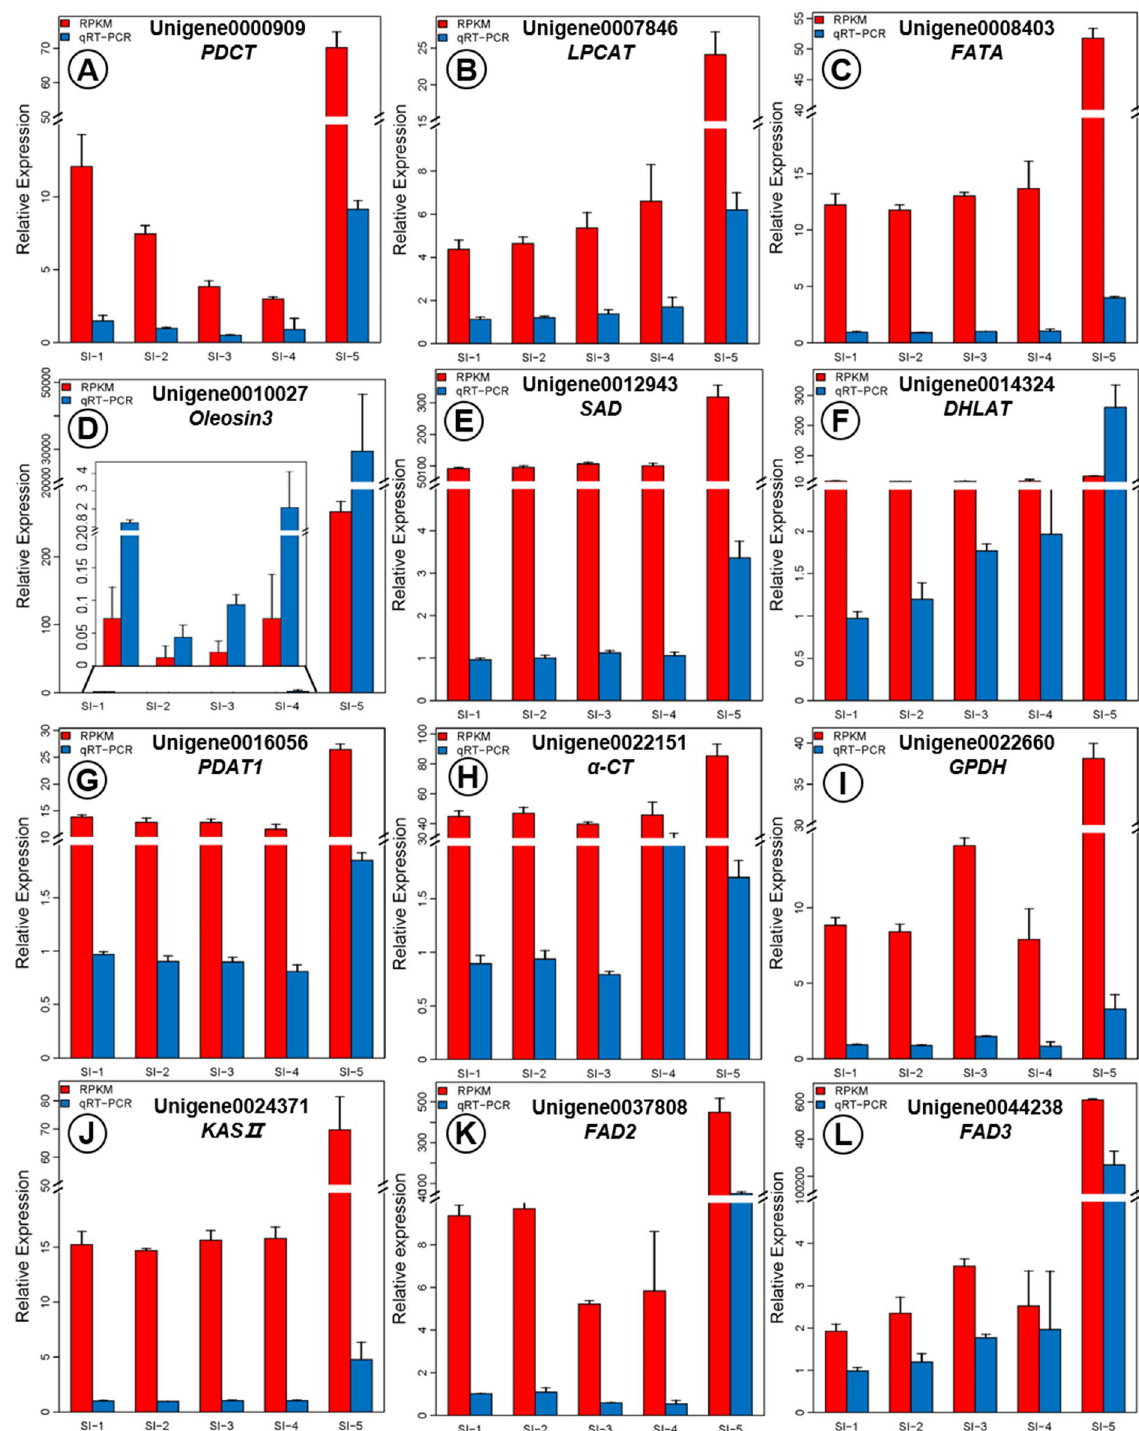
Figure 9. The expression levels of the 11 candidate unigenes related to ALA biosynthesis and PUFAs content as revealed by qRT-PCR and RNA-seq ( A – L